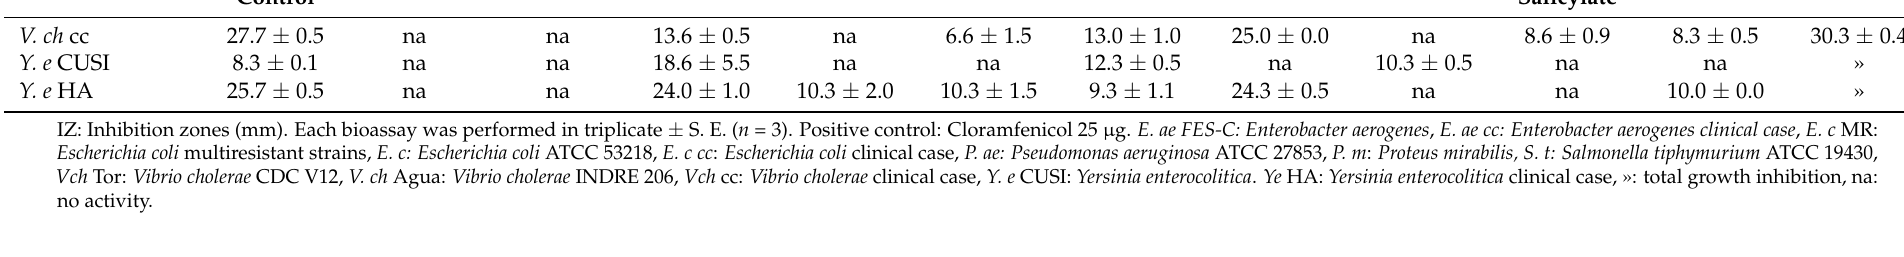
Table 3. Antimicrobial activity of some compounds in yeast